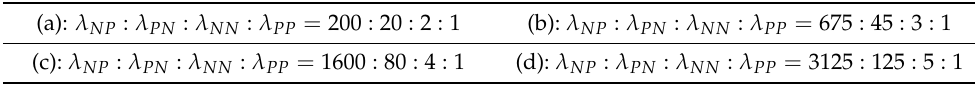
Table 1. Risk coefficient